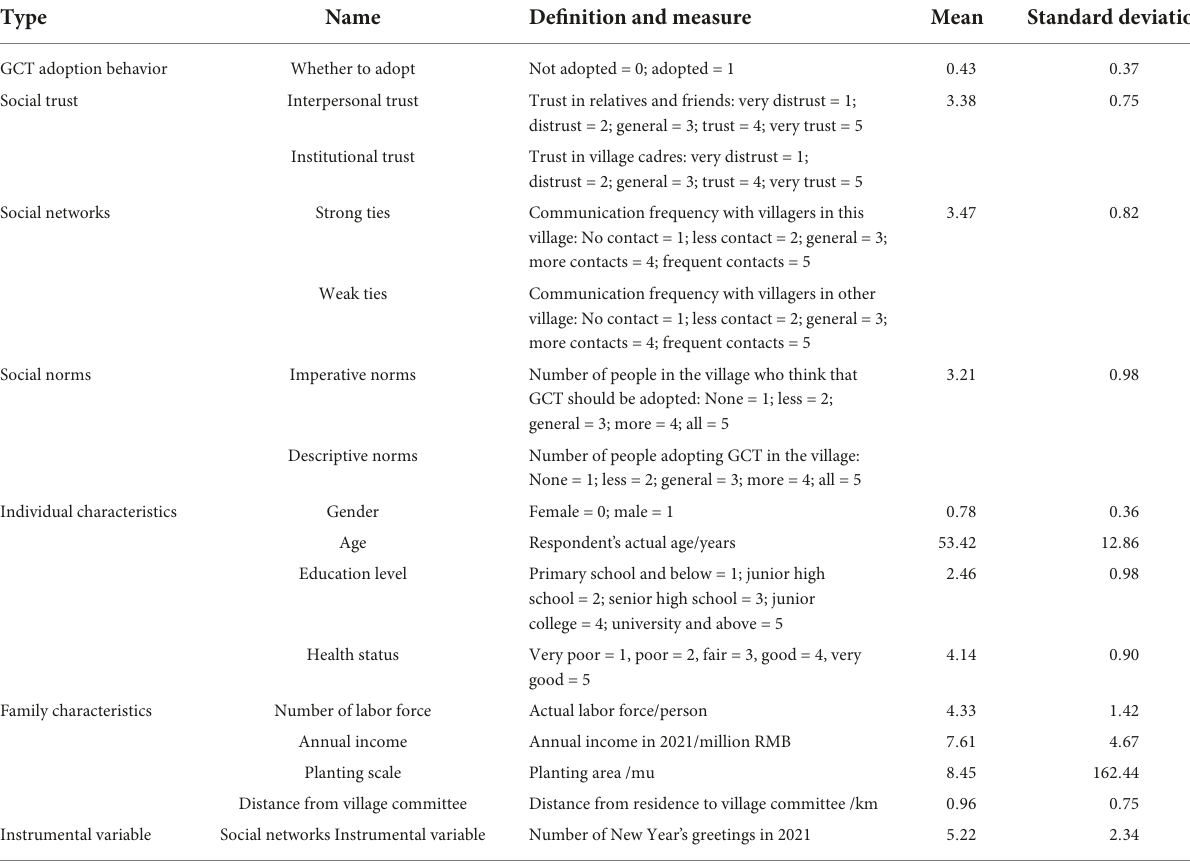
TABLE 1 Variables definition and descriptive